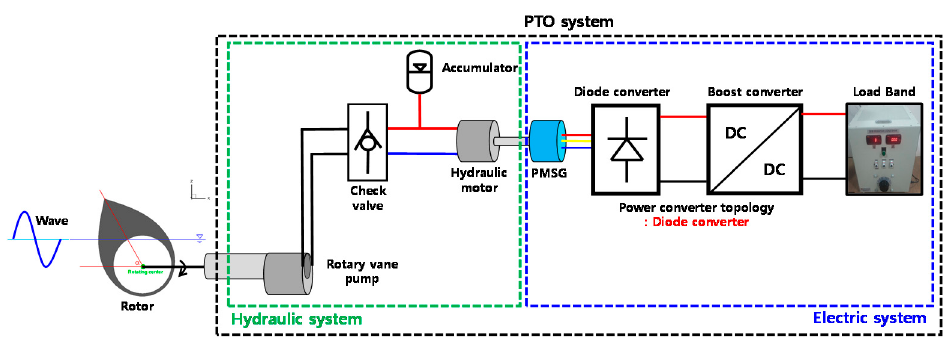
Figure 2. FWEC power conversion chain.